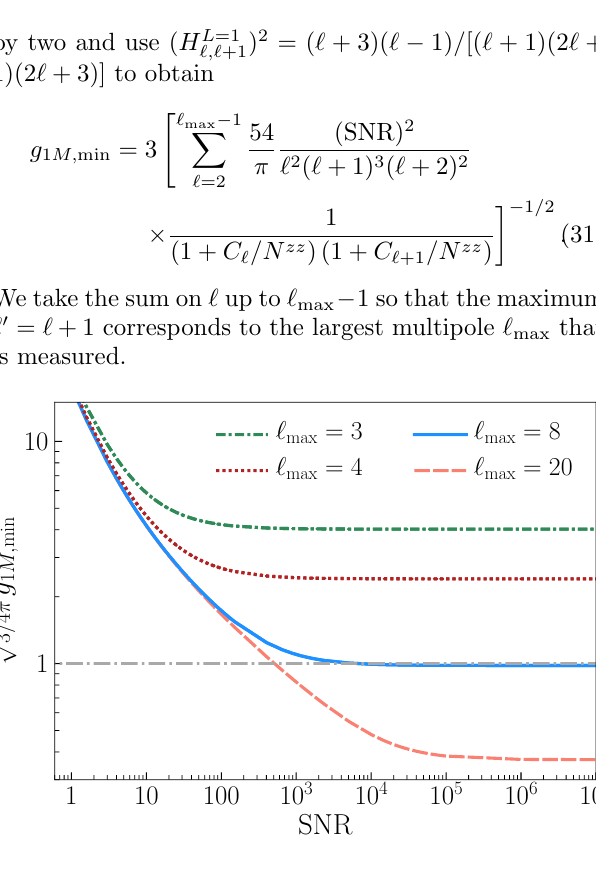
FIG. 1. The smallest detectable (at the 3 σ level) dipole- anisotropy coefficient g 1 M (multiplied by are shown as a function of the signal-to-noise ratio for the isotropic GW signal and for several values of the maximum timing-residual multipole moment (cid:96) max (which is (cid:96) max (cid:39) (cid:112) N p in terms of the number N p of